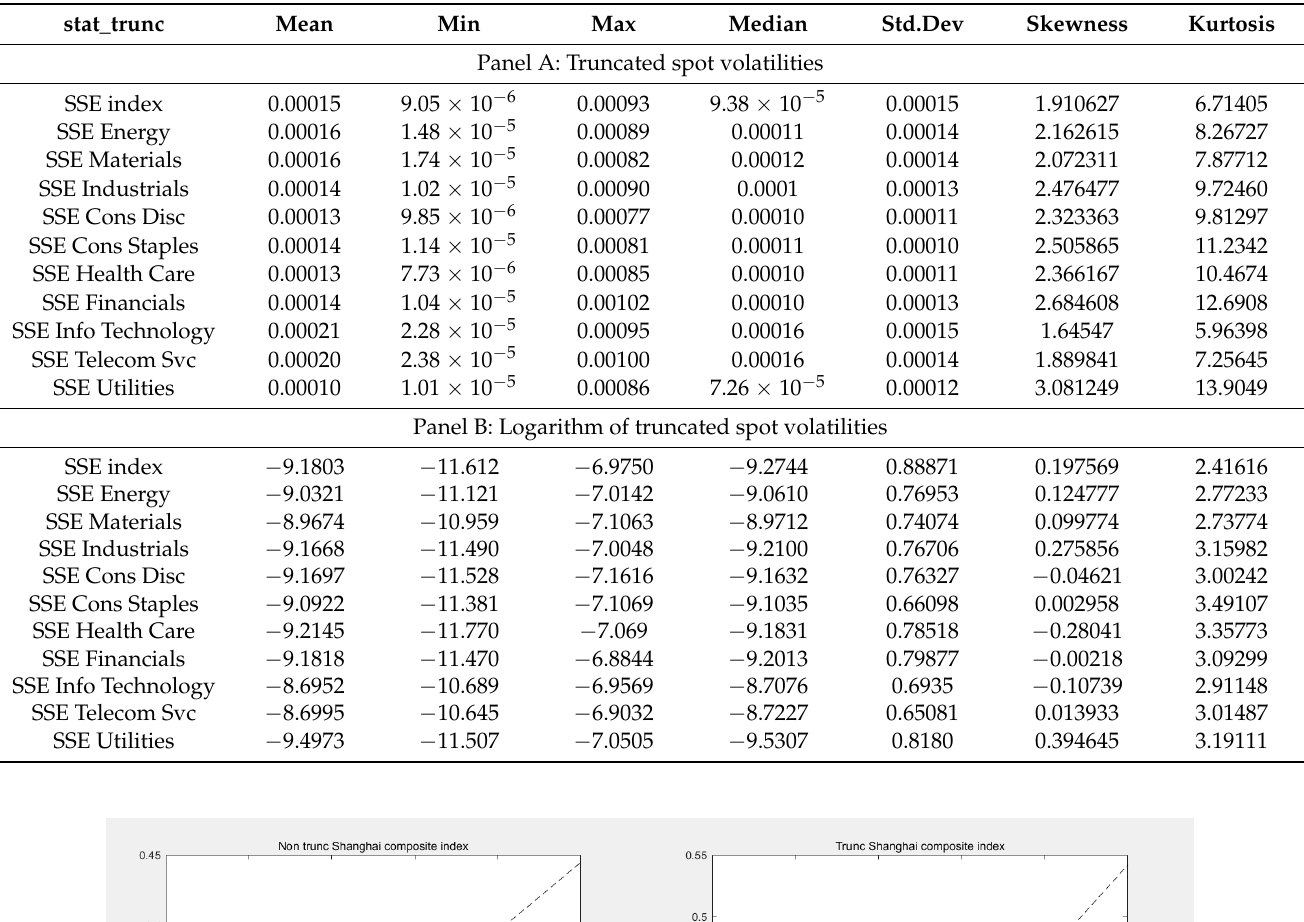
Table 4. Descriptive statistics for the truncated spot volatilities and their logarithms.